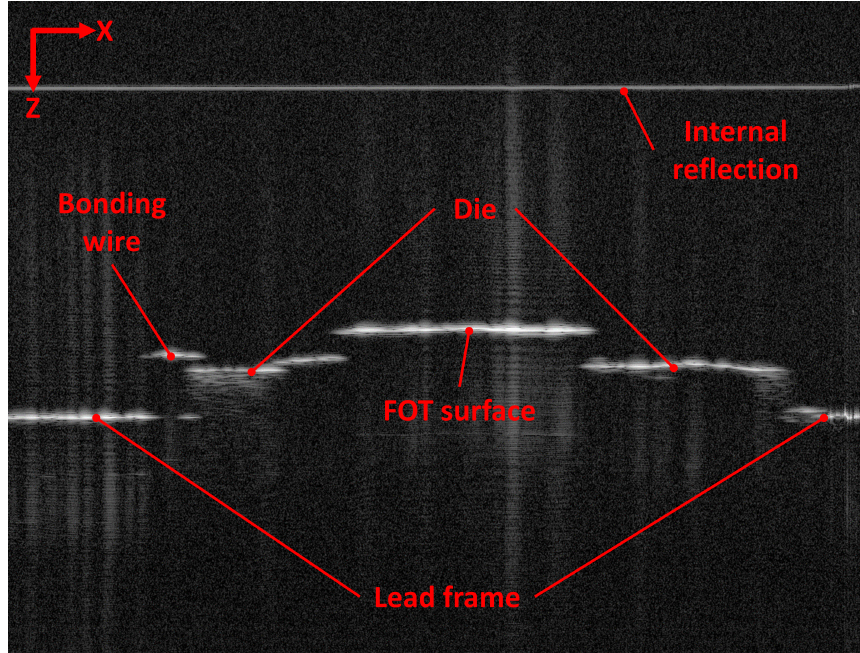
Figure 8. Typical B-scan image of non-overmoulded FOT. Apart from the LED’s upper surface, several other features can be identified. This includes the die on which the LED is mounted, the lead frame and the bonding wires. Additionally, unwanted signals due to internal reflections in the beam path might occur. The algorithm has to make sure that these parasitic signals do not interfere with the desired signals.